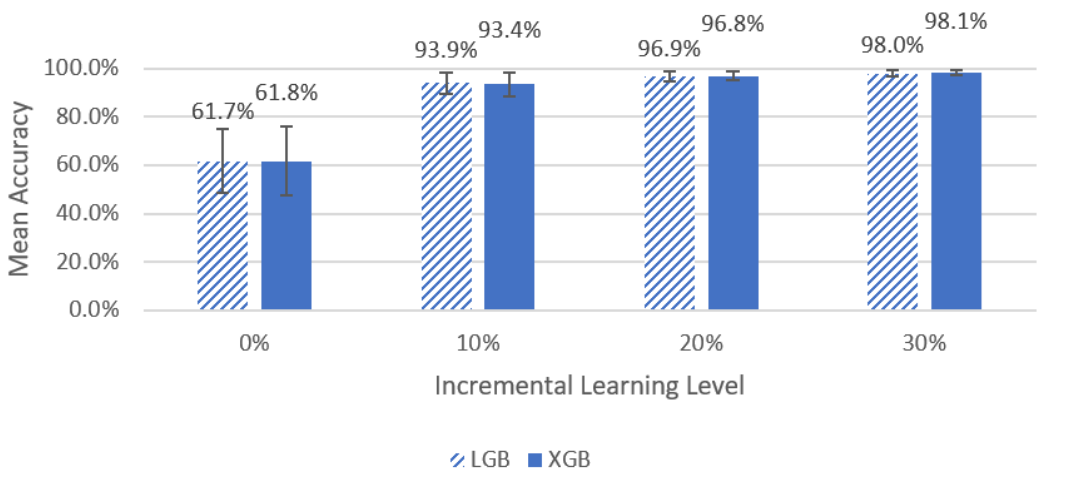
Figure 5. Graph of left-side lying, right-side lying, or supine classification mean accuracy for the LGB and XGB models across the four different incremental learning levels. The error bars represent standard